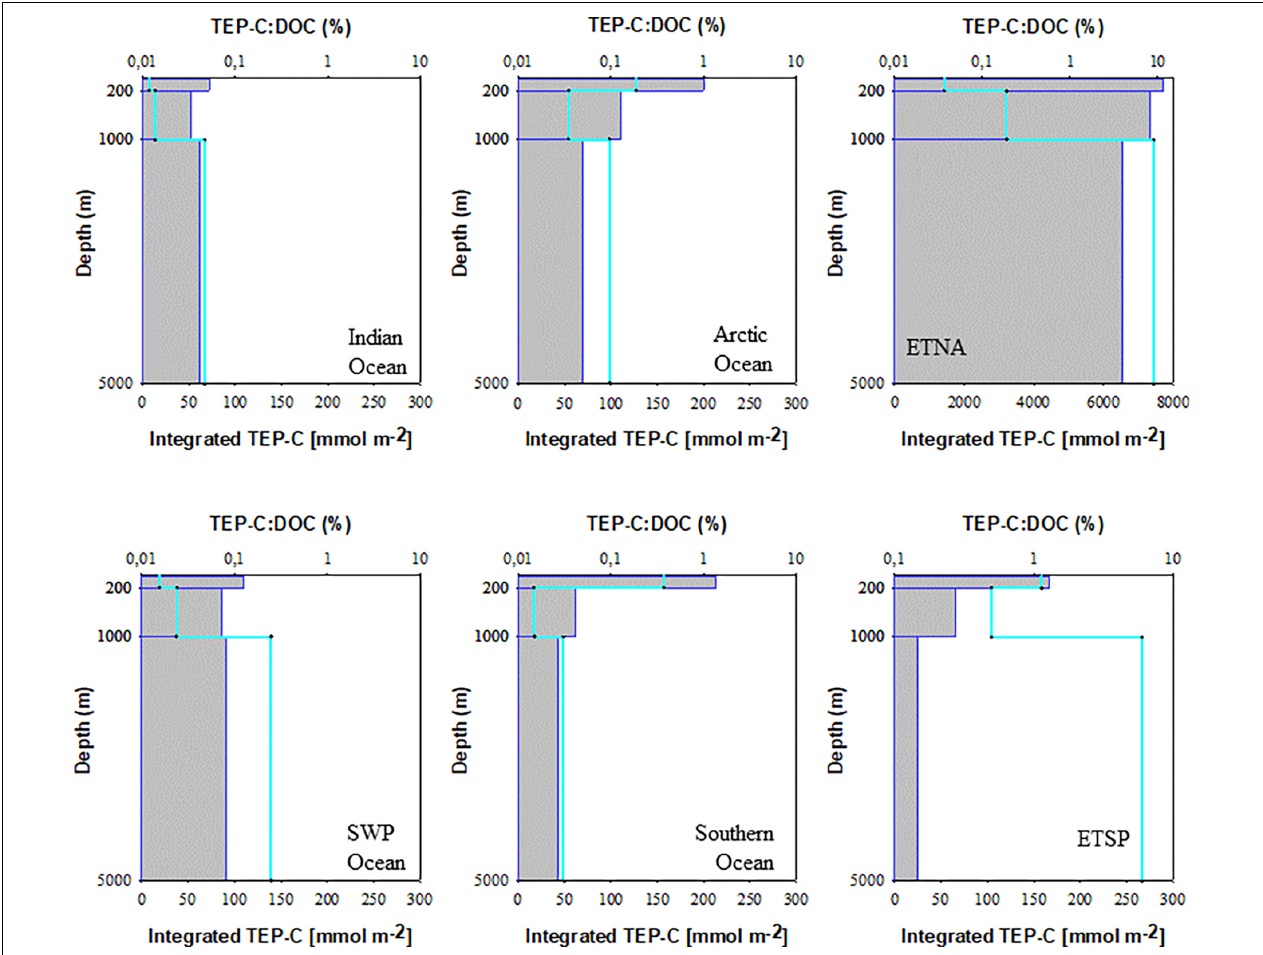
FIGURE 5 | Depth-integrated carbon content of TEP (green line) and TEP-C percentage of DOC (gray bars) for the three studies depth layers of the six study